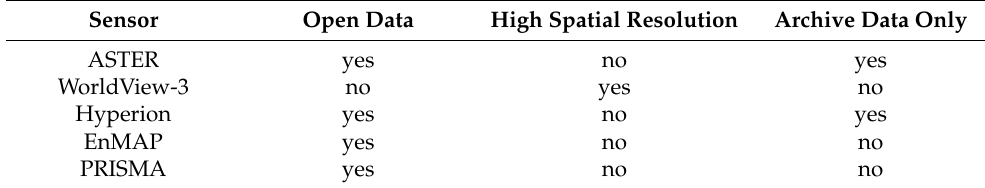
Table 2. Summary table for sensors that show suitable channel configurations for the differentiation of plastics in the environment. Sensor Open Data High Spatial Resolution Archive Data Only ASTER yes no yes WorldView-3 no yes no Hyperion yes no EnMAP